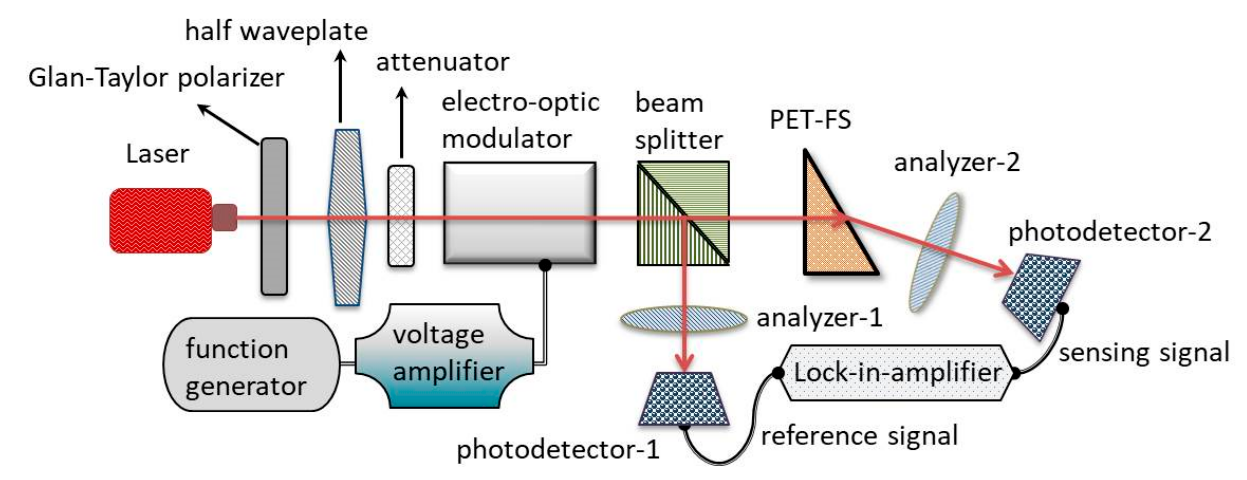
Figure 2. A setup for monitoring the fluidic concentration variations.